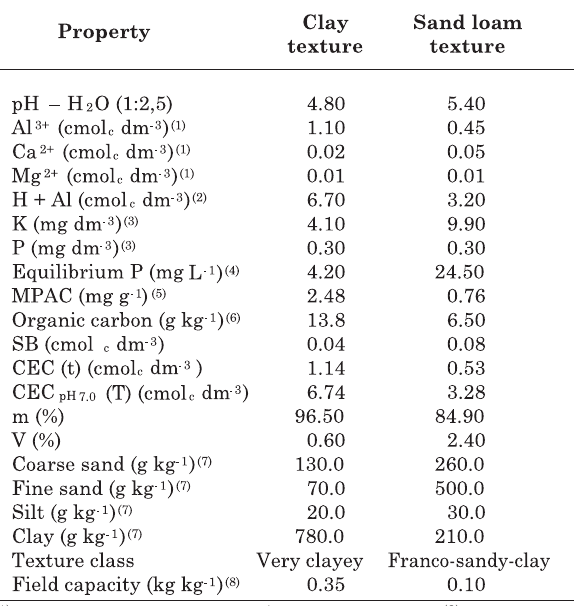
Table 1. Chemical and physical properties of soil